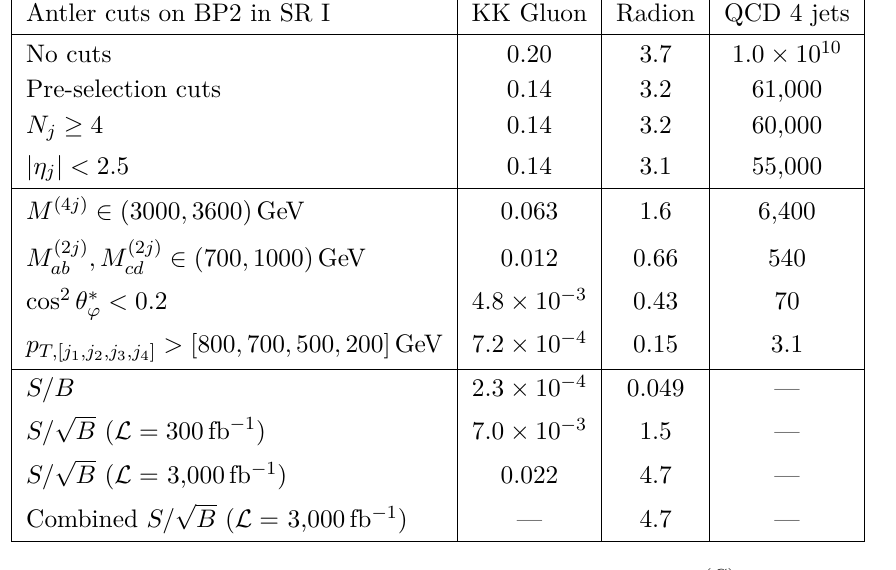
Table 3 . Cut flows of BP2 in SR I ( g grav = 6 , g g 3 . 3 TeV , and m ϕ = 1 TeV , see also table 1) and QCD 4-jet backgrounds. The same explanations including the pre-selection cuts as in the caption of table 2 are